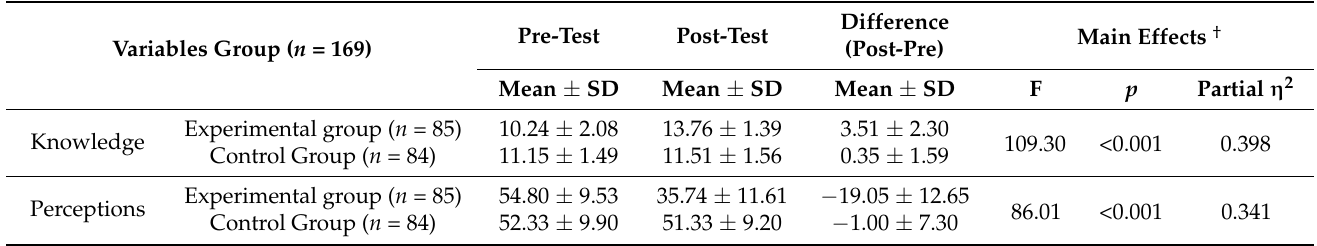
Table 3. Educational effects on main outcome variables ( n = 169).